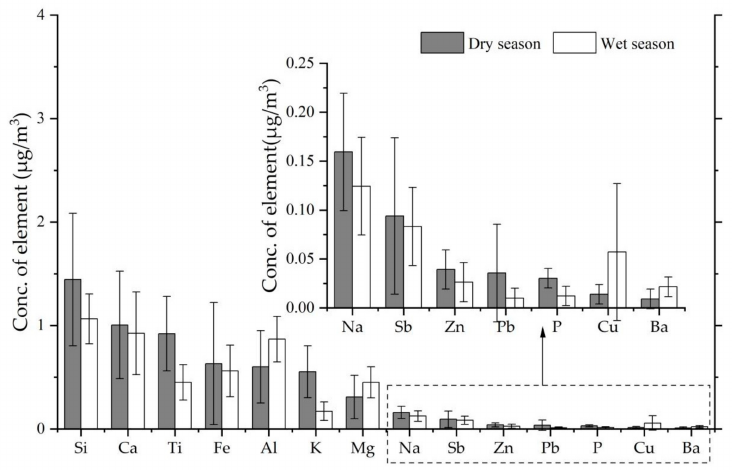
Figure 4. Mean concentrations of inorganic elements in PM 2.5 sampled at